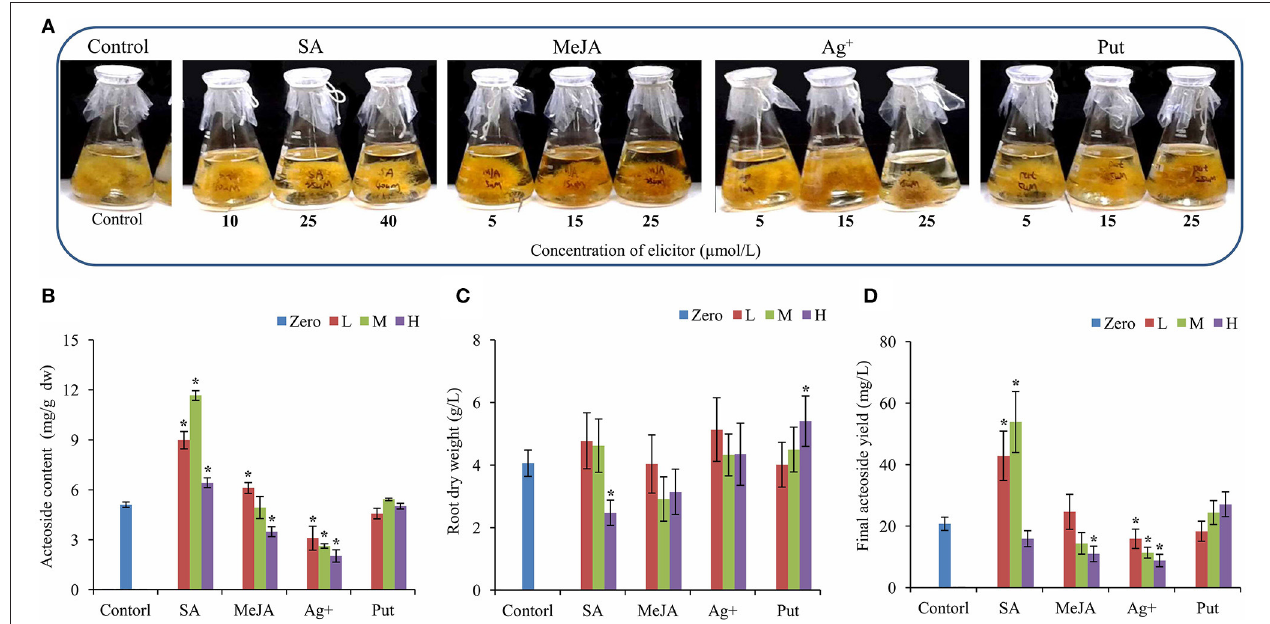
FIGURE 1 | Effects of elicitors on root growth and acteoside content of R. glutinosa hairy roots. (A) Growth status of hairy roots with elicitors. (B–D) Root dry weight (A) , Acteoside content (B) and final acteoside yield (C) of the R. glutinosa hairy roots after SA, Ag + , MeJA, and Put treatment. The vertical bars show the SD values ( n = 3). The asterisks indicate statistically significant differences at p < 0.05. L, lower concentration; M, middle concentration; H, higher concentration.